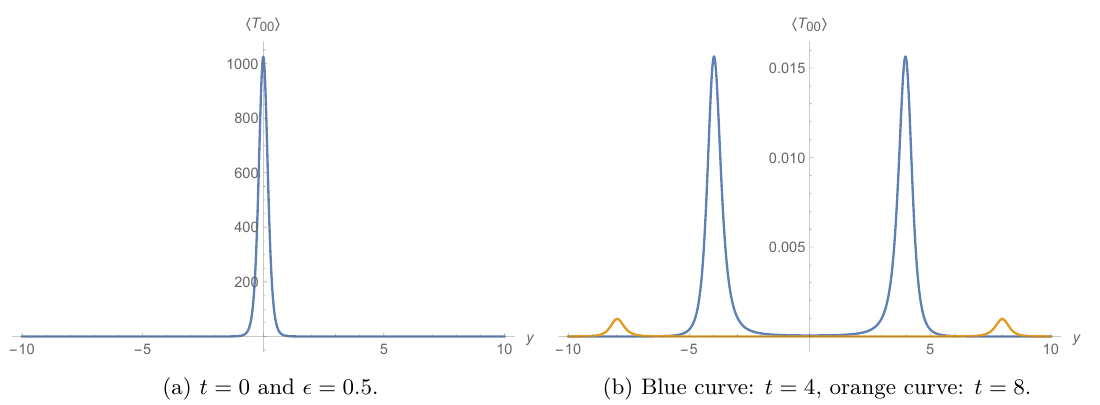
Figure 4 . Energy density profile for the local quench created by field strength F ty at times t = 0 , 4 , 8 with width (cid:15) = 0 . 5